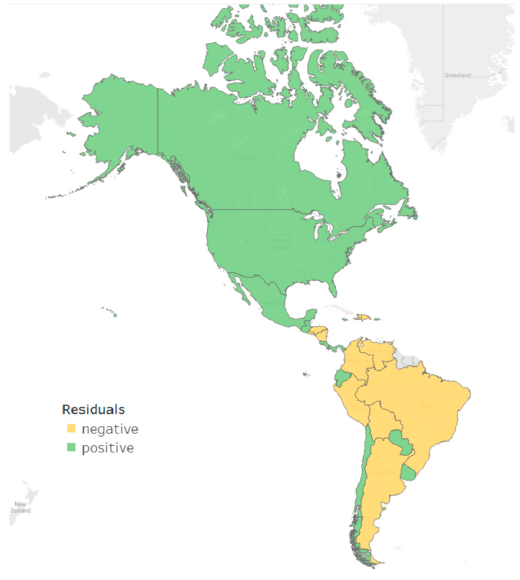
Figure 12. Moran’s I distribution for residuals for the ETI OLS model in North and South America. In terms of System Performance, as for ETI, spatial dependencies are noticeable in Europe. In the original synthetic SP measure in America, its optimised version does not emphasise such a feature. In the case of System Performance, the explanatory abilities were better for those variables relating to the general development of the economy, i.e. the degree of urbanisation positively influences SP in America (both models) and Europe (optimised version). Employment in the industry positively impacts the SP value in America, while it is negative in Europe and Asia (original version). On the other hand, the degree of urbanisation positively influences the optimised SP values on the American and European continents. Table 6. Estimation results for system performance (new and optimised) for different continents. Variable